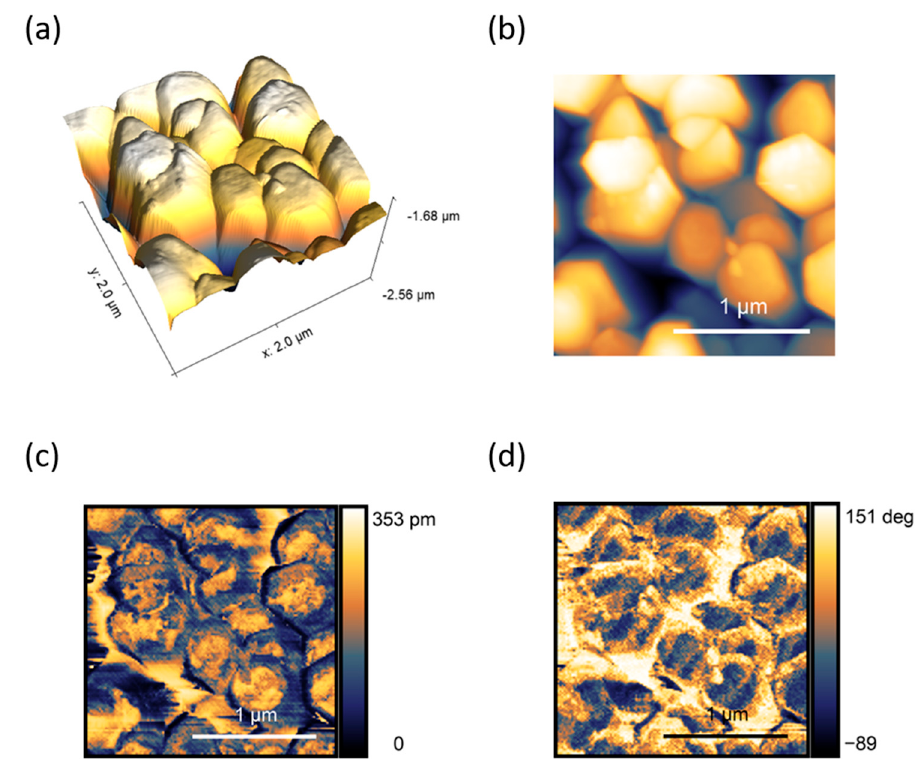
Figure 4. SPM images of seedless grown ZnO NRs on annealed Au-coated Si substrate. ( a ) 3D rendering of the top surface of the NRs; ( b ) Topographic false color map of the same region; corresponding PFM signal in ( c ) Amplitude and ( d ) Phase.